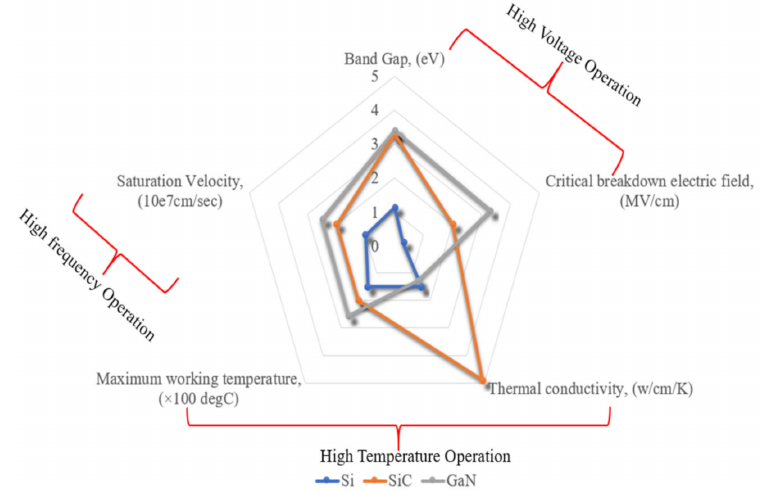
Figure 1. Characteristics of Si, SiC, and